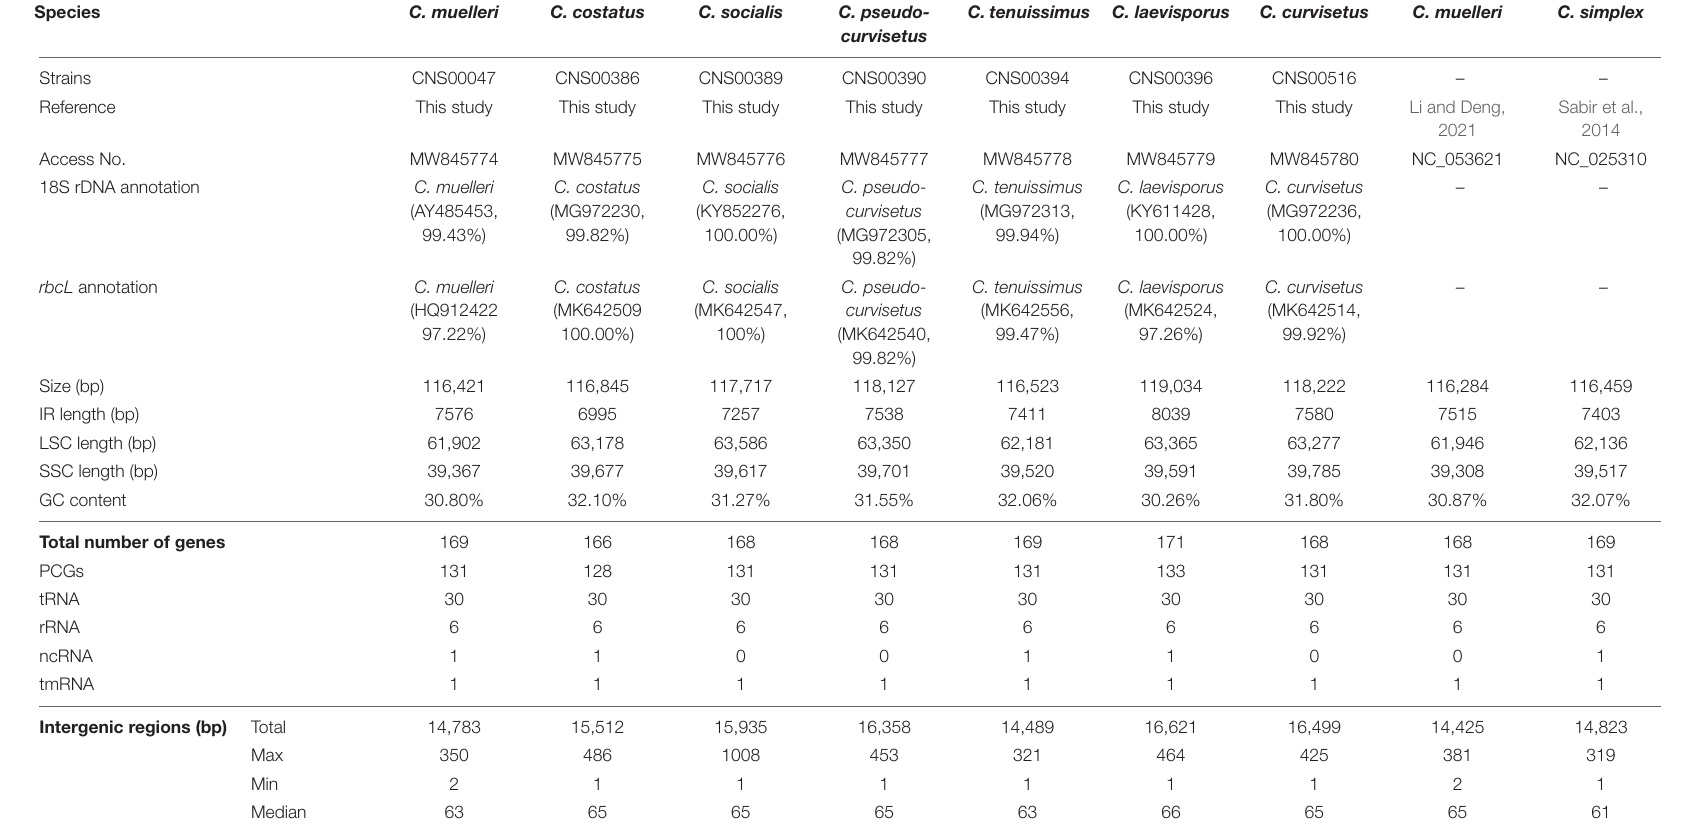
TABLE 1 | Basic characteristics of Chaetoceros